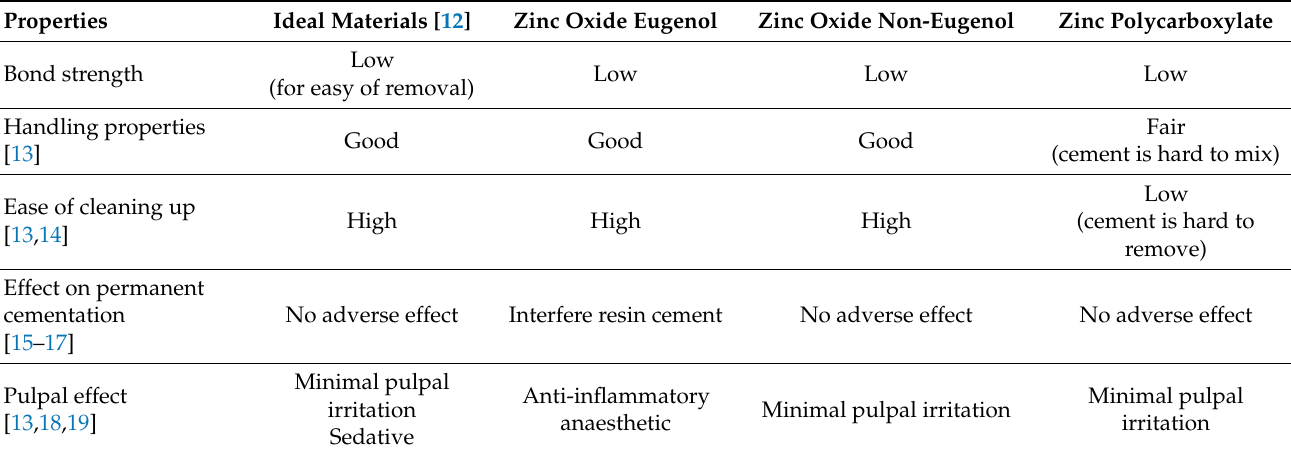
Table 1. Properties and the types of temporary luting cements.